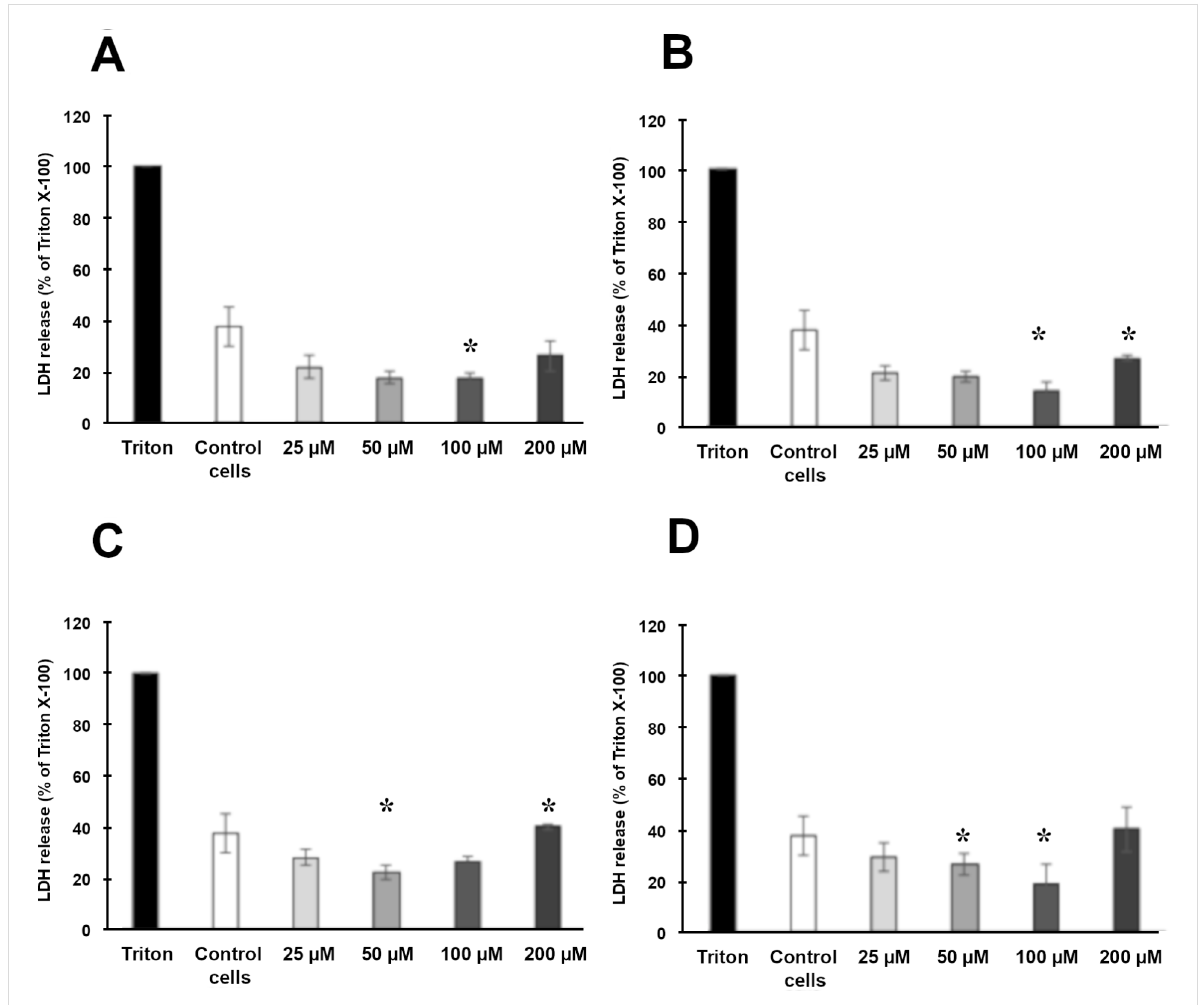
Figure 4: Cytotoxicity of NLC T10-TOC (A), NLC C10-TOC (B), NLC P10-TOC (C) and NLC S10-TOC (D) evaluated by LDH release from HaCaT cells in the media after 24 h of treatment. Data are expressed as percentage LDH release as compared to the maximum release of LDH from Triton- X100-treated cells. Data are given as mean ± SD, representative of three independent experiments with at least three technical replicates each time. * indicates statistically significant difference to untreated control cells (unpaired t -test, p <